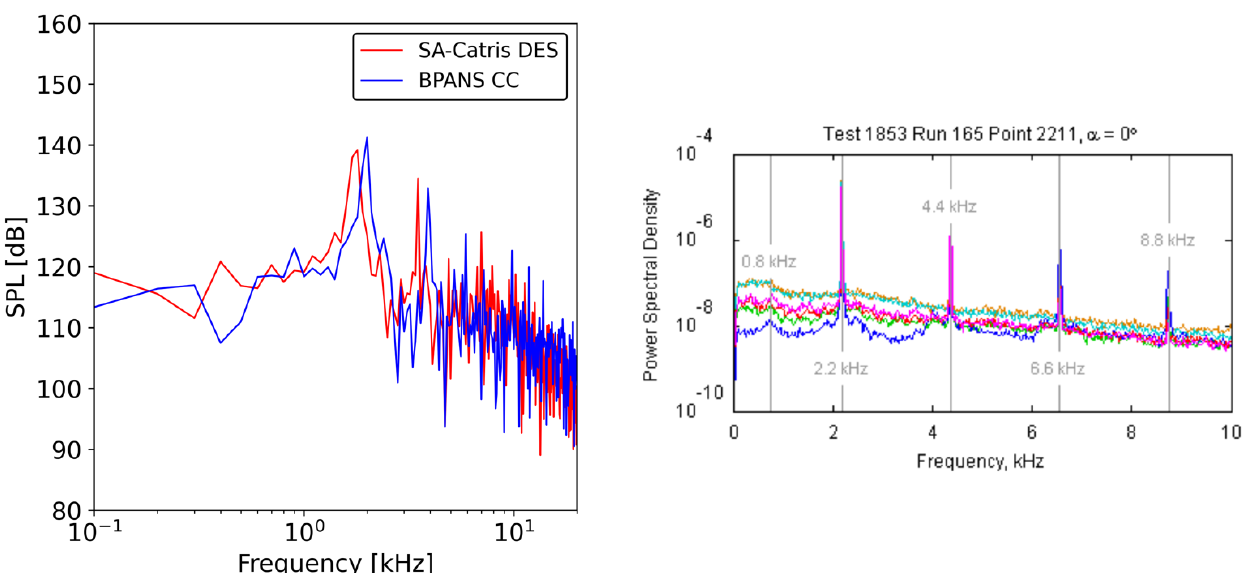
Figure 14. Pressure spectra plot for BPANS CC ( f k = 0.2 ) and SA-Catris DES compared to experi- mental data